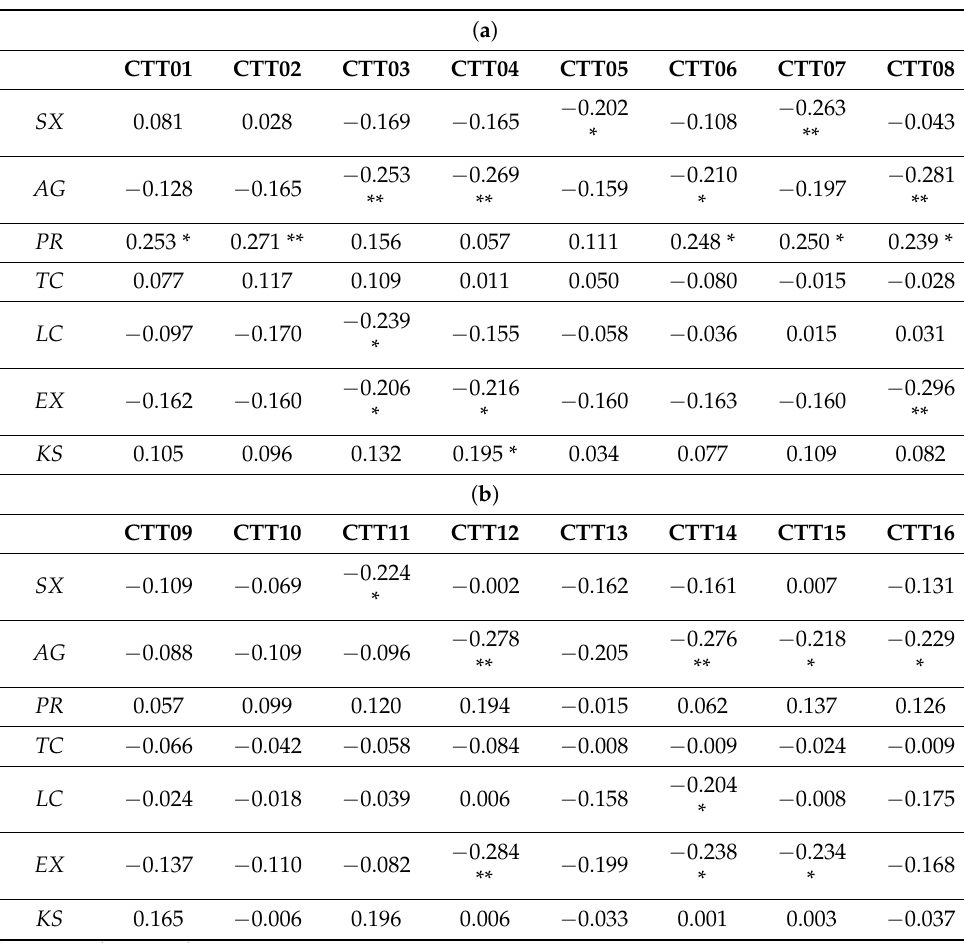
Table A4. ( a , b ) Spearman correlation matrix: knowledge of content creation